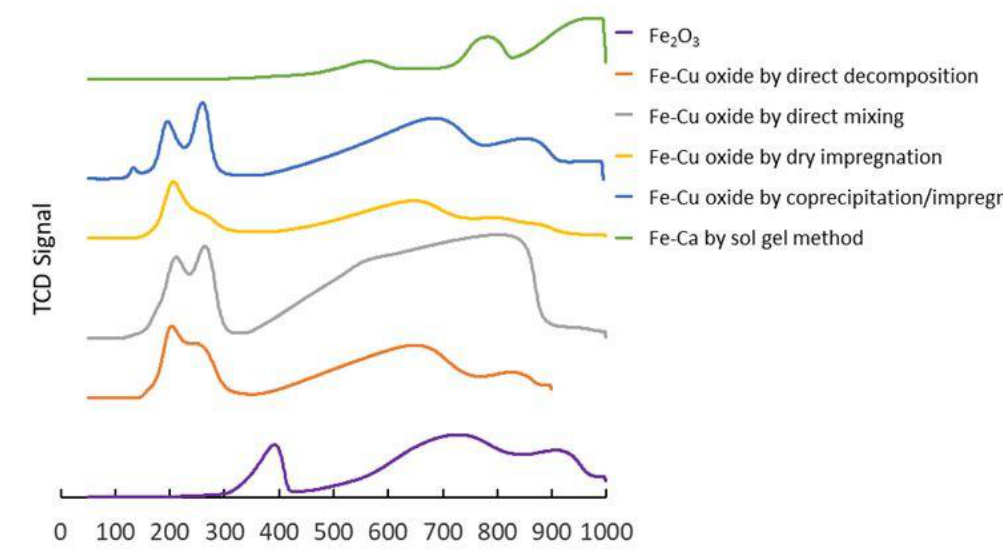
Figure 3. H 2 -TPR of oxygen carriers prepared by di ff erent methods.